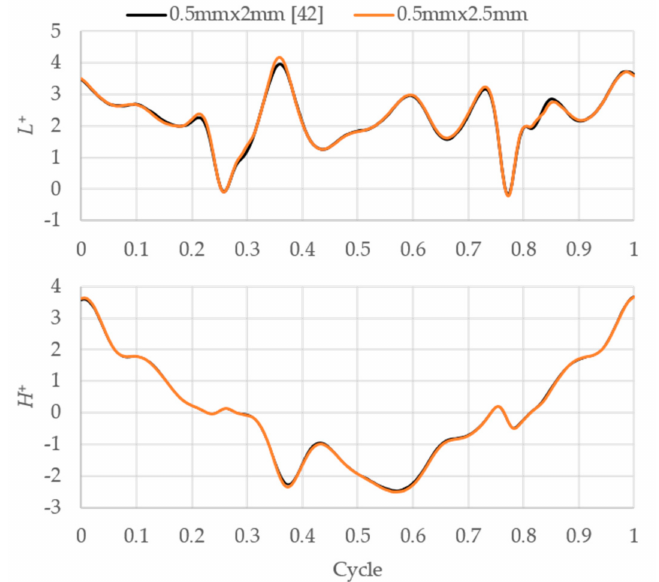
Figure 11. The non-dimensional forces for the wing distance of 16 mm at hovering computed from the current mesh and from the finest mesh used in the previous work. Reprinted from Ref.